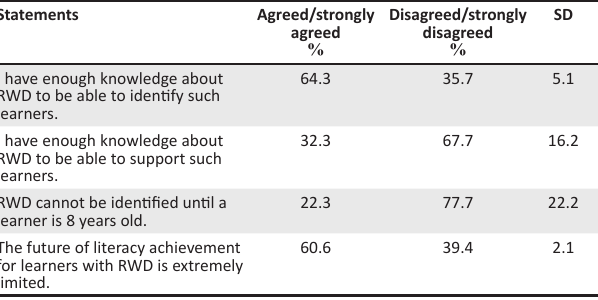
TABLE 2: Participants’ perspectives on their ability to identify and support learners with reading and writing difficulties.